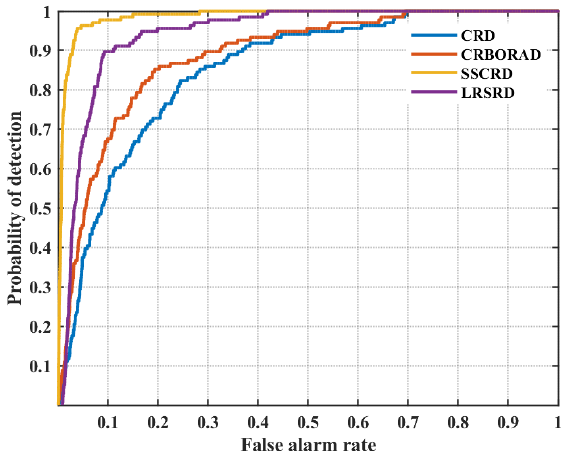
Figure 5. ROC curves for San Diego-II dataset with dual-window sizes (9,13) for CRD, CRBORAD, and SSCRD.